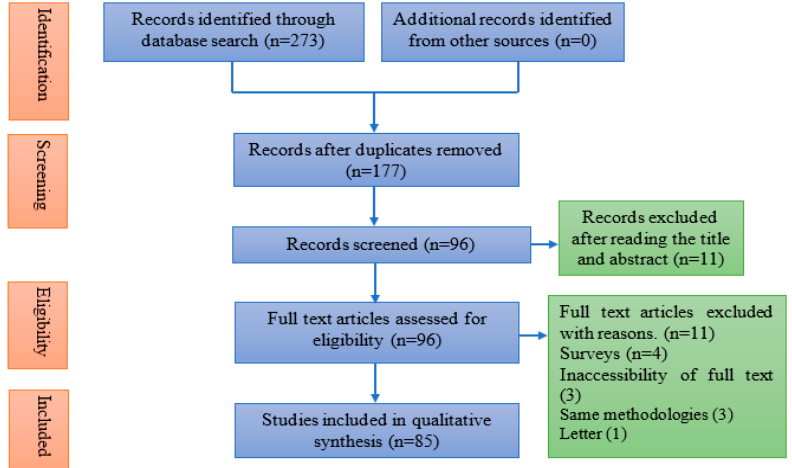
Figure 1. Prisma Figure 1. Prisma flowchart.